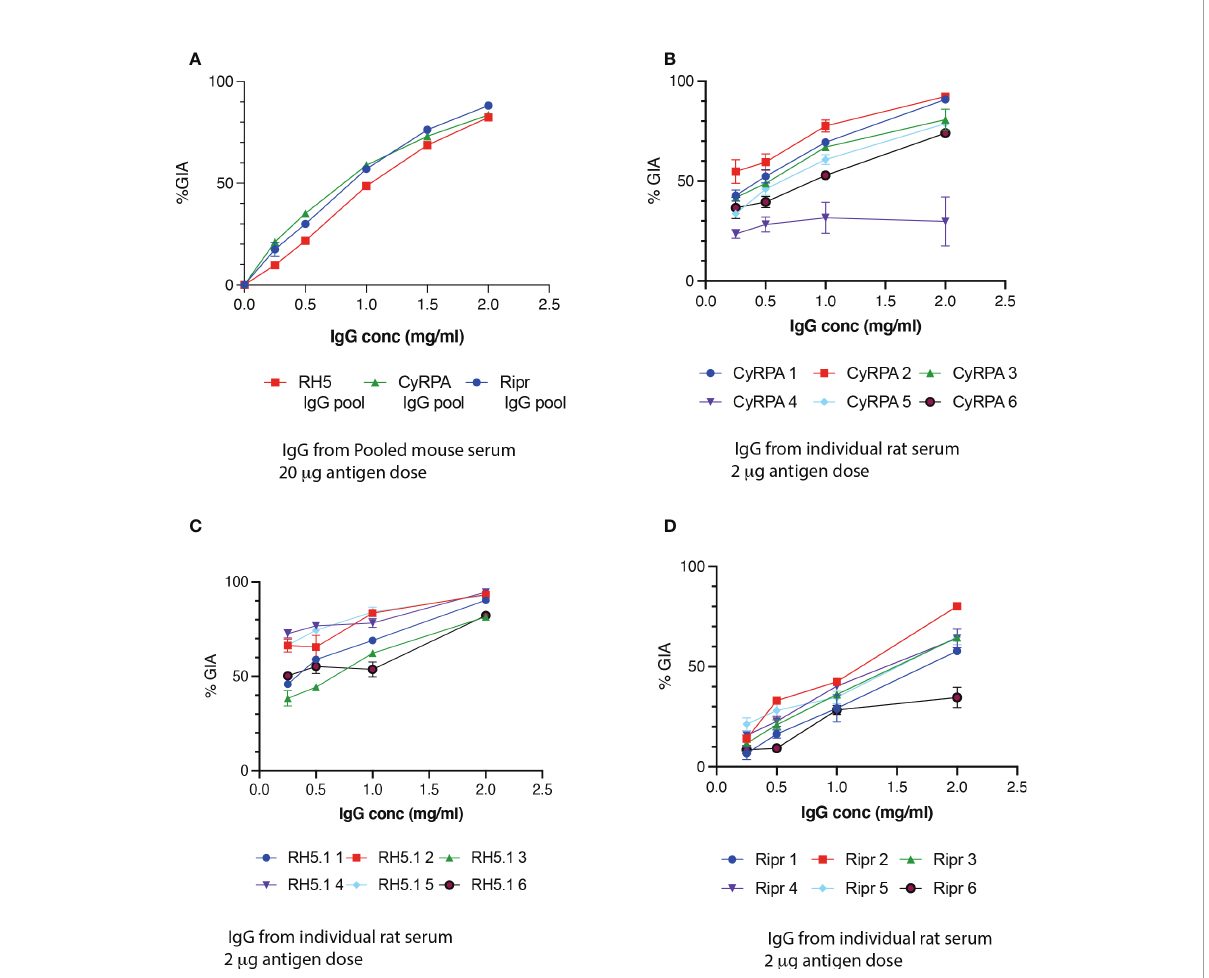
FIGURE 2 DPX-formulated candidates induce P. falciparum growth inhibitory antibodies against RH5, CyRPA and Ripr in mice and rats. (A) A GIA assay was performed with IgG pooled from 6 mice immunized with 20 m g antigen formulated with DPX - RH5 (red squares), CyRPA (green triangles) or Ripr (blue circles). Intra-cohort variability in GIA of IgG from six individual rats immunized with 2 m g antigen - RH5.1 (B) CyRPA (C) and Ripr (D) antigens were formulated with DPX. Error bars represent SEM of triplicate